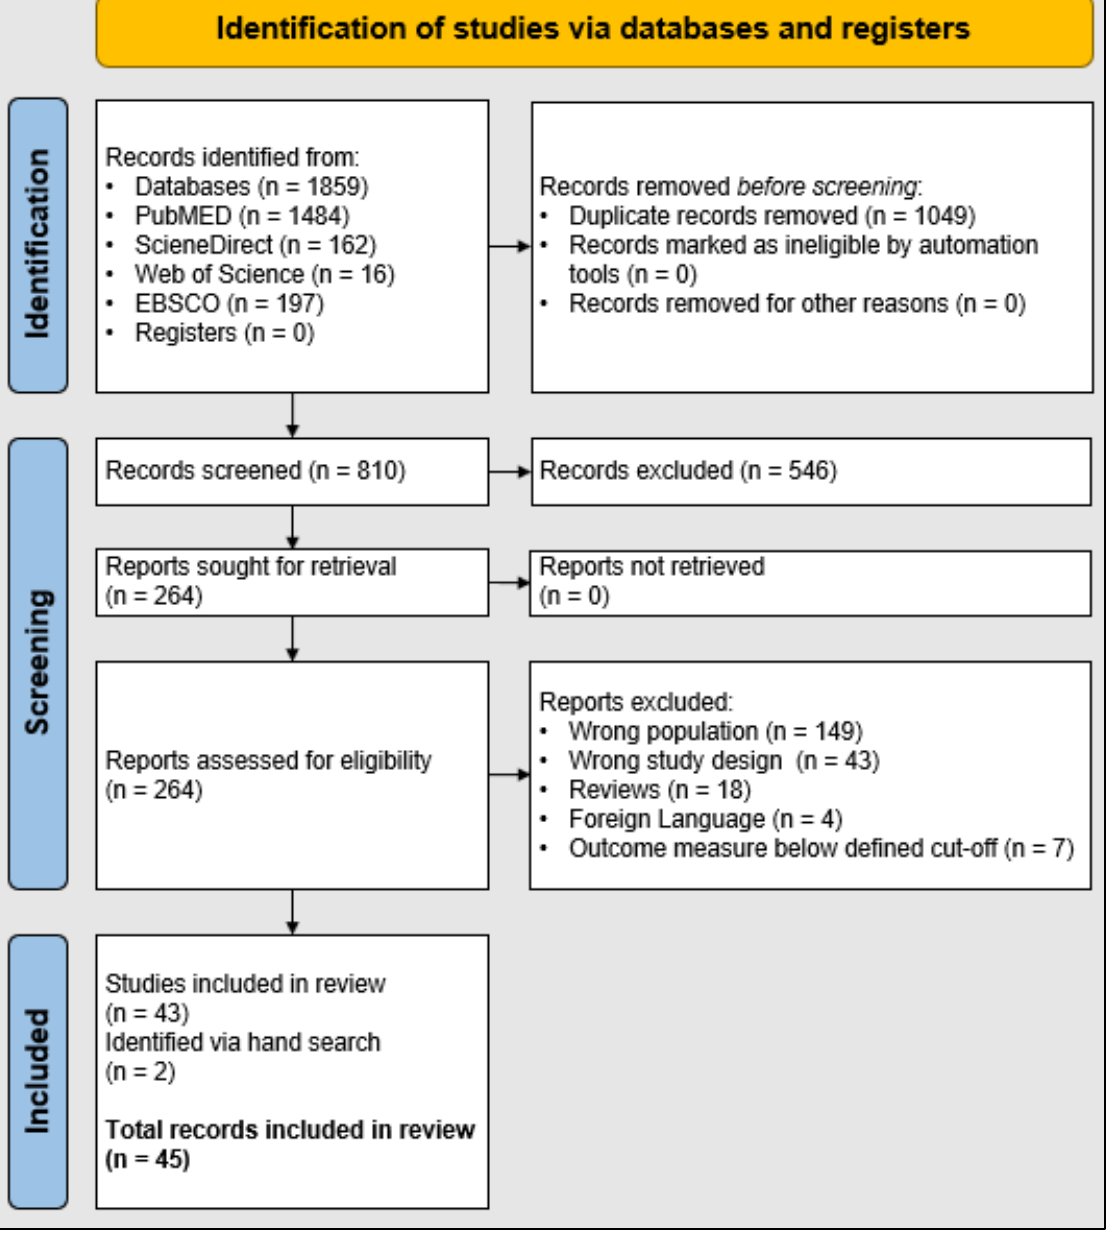
Figure 1. PRISMA flow chart for the identification of studies.